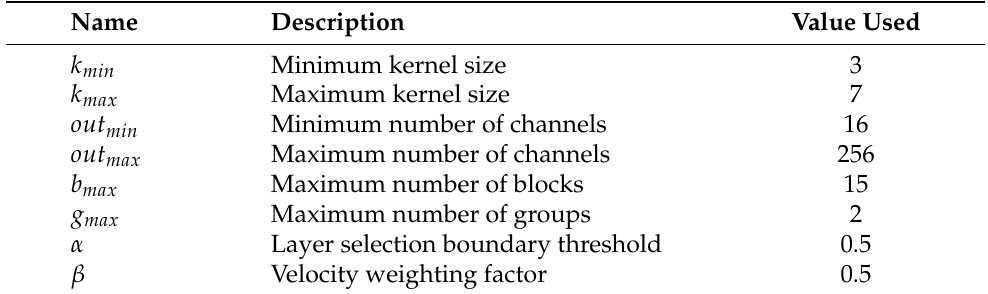
Table 4. Algorithm settings and the search space in our experiments. We adopt the settings to closely match those of existing studies [15,51], to ensure a fair